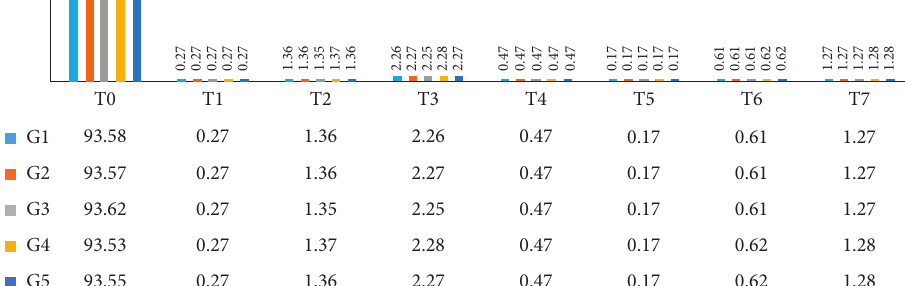
Figure 5: Energy proportion.